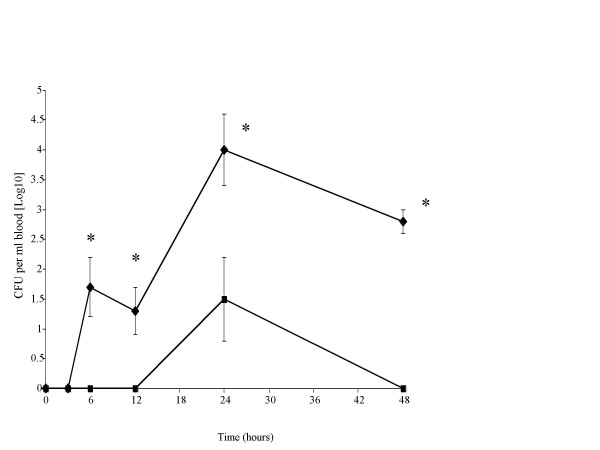
Time course of the change in numbers of S. pneumoniae in the nasopharynx (figure 1), trachea (figure 2), lungs (figure 3) and blood (figure 4) of SP-D-/- (◆) and SP-D+/+ (■) mice infected intranasally with 106 CFU (n = 10 mice at each time point, error bars indicate SEM). * denotes P < 0.01, ** denotes P < 0.05 for SP-D-/- when compared to wildtype at equivalent time point.